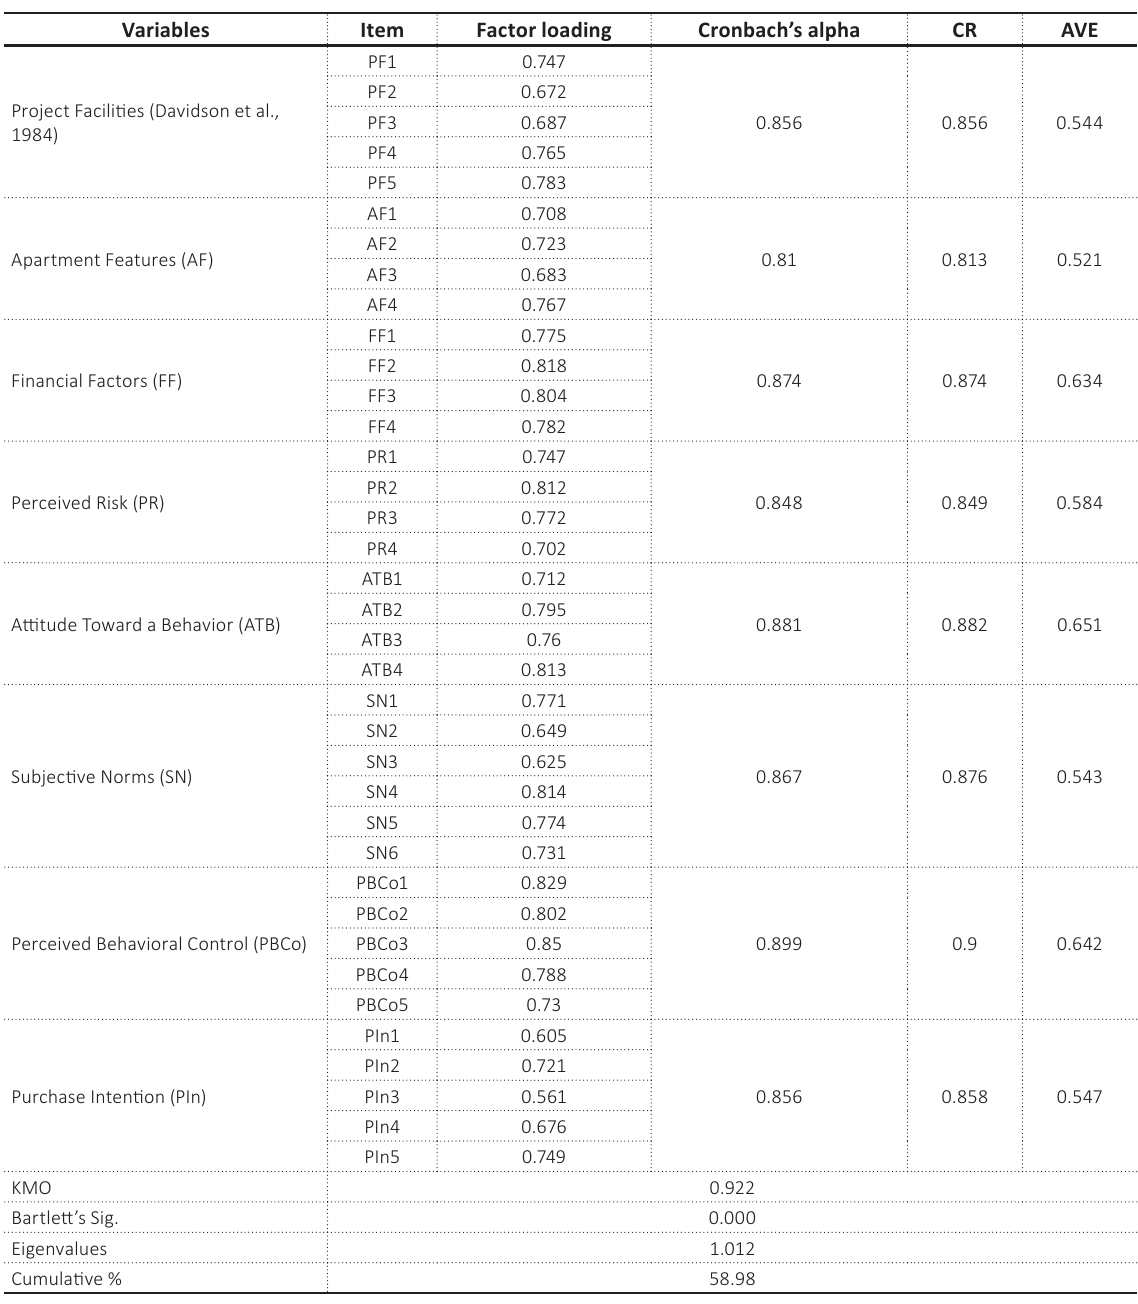
Table 2. EFA and CFA index